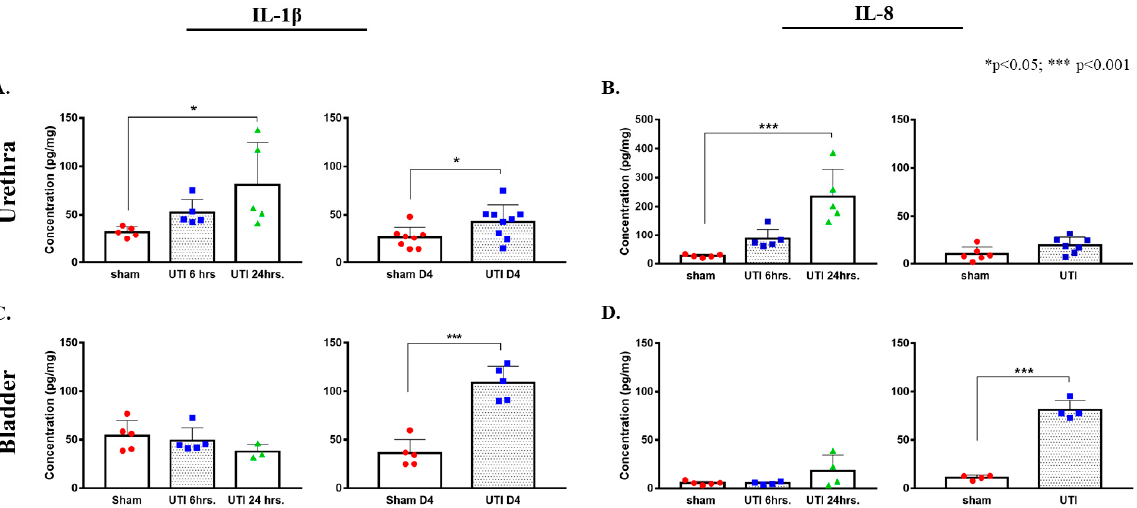
Figure 3. Increased protein concentrations of IL-1 β and IL-8 in urethra and bladder tissues in ELISA assay. Concentration of IL-1 β ( A ) and IL-8 ( B ) in urethra tissues of rats with a UTI and sham rats at 6 h, 24 h, and day 4 (D4) post infection. Concentration of IL-1 β ( C ) and IL-8 ( D ) in bladder tissues of rats with a UTI and sham rats at 6 h, 24 h, and day 4 post infection. Determination of significance between the sham and UTI group at 6 and 24 h was generated using one-way Anova followed by Tukey’s multiple comparison’s test. Determination of significance between the sham and UTI group on day 4 post infection was done using an unpaired Student’s t -test.